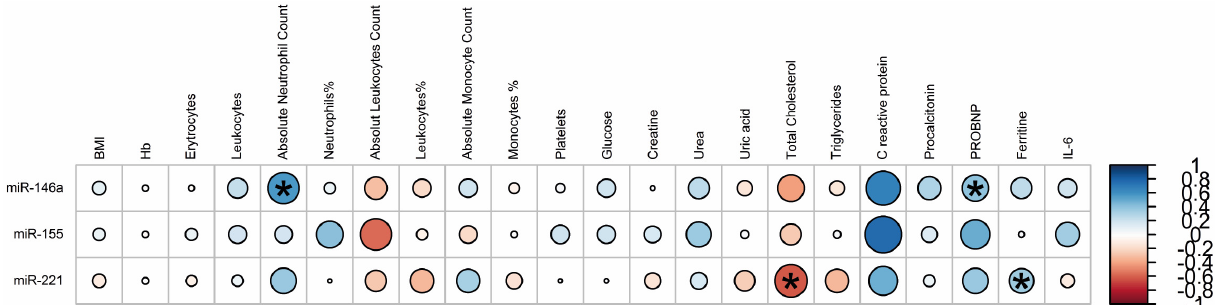
Figure 4. Correlations between significant miRNAs and clinical characteristics. Blue circles represent positive correlations, while red circles represent negative correlations. Significance of correlation is, accordingly, the circle diameter. Spearman’s correlation (* p < 0.05).